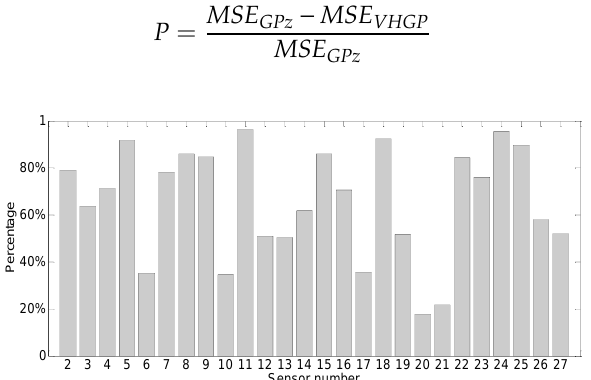
Figure 12. Accuracy improvement by VHGP as compared with GPz.